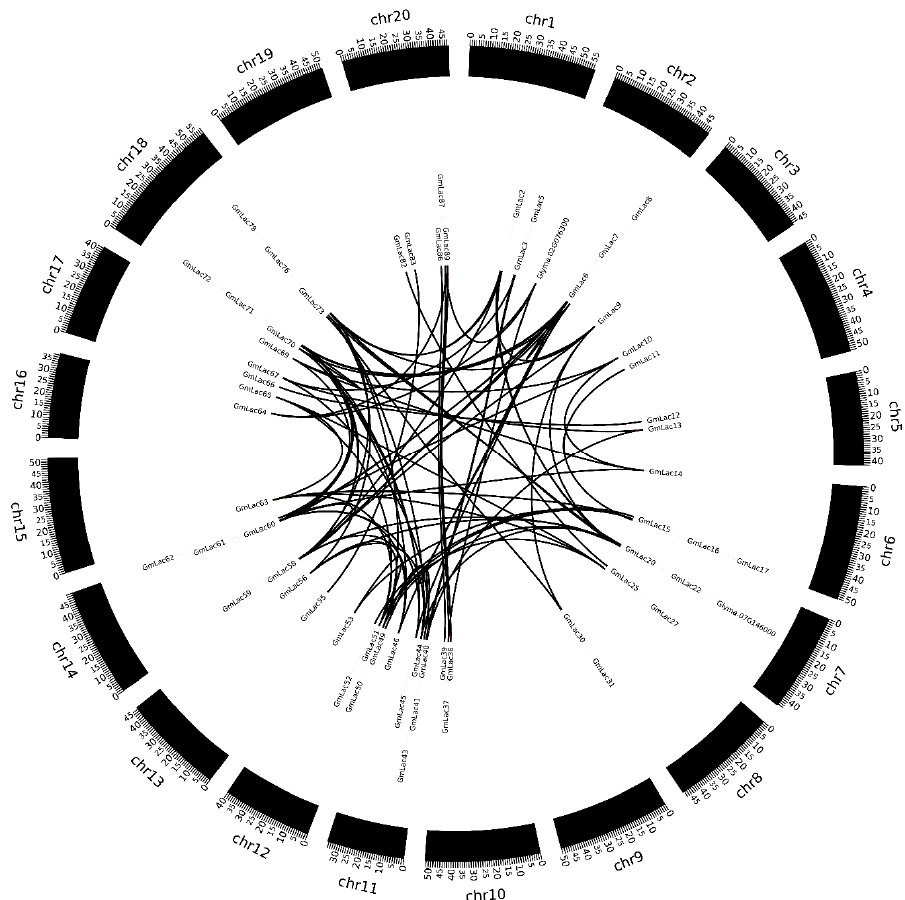
Figure 3. Collinearity of the laccase gene ( GmLac ) gene pairs. The outermost scale represents the chromosomes. Genes are listed in the inner circle according to their chromosomal location. Synteny relationships between gene pairs are marked with a black line .